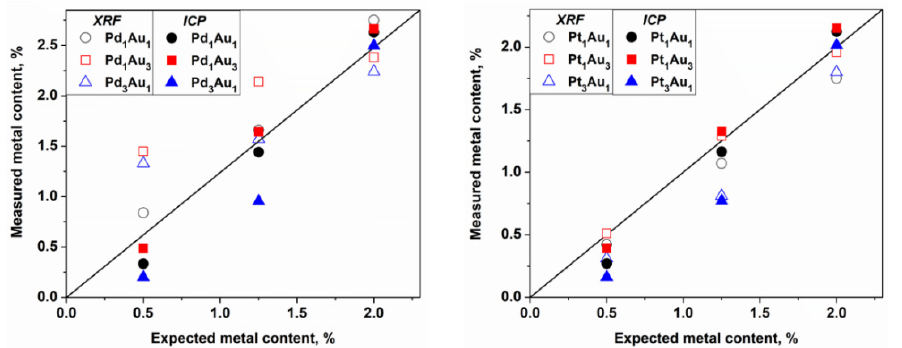
Figure 6. Real metal loading measured by XRF and ICP compared with the theoretical values (black line).